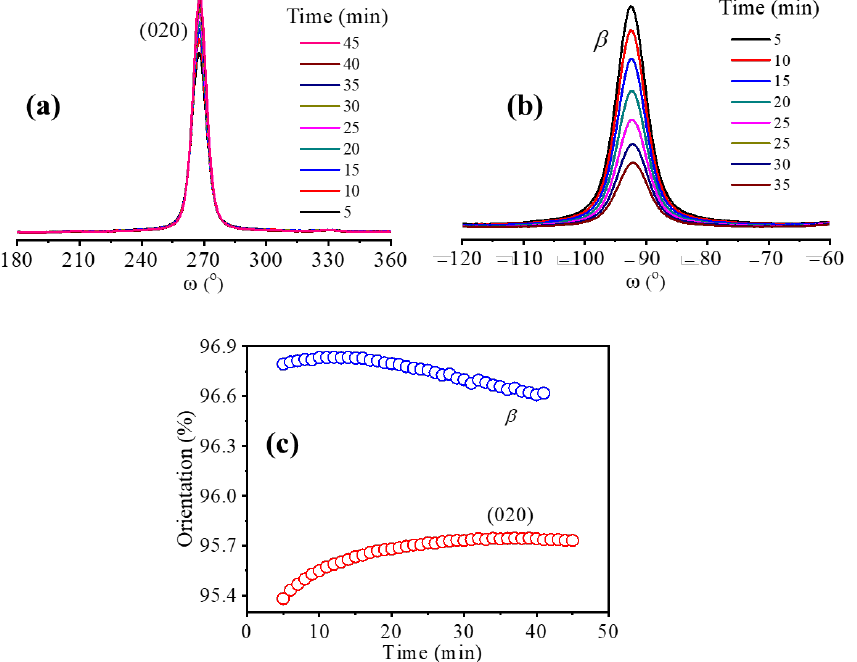
Figure 6. ( a ) Azimuthal intensity distribution of (020) α reflection and ( b ) β reflection; ( c ) changes in orientation of (020) and β reflections of two-step-drawn PHBV films during annealing at 130 °C.